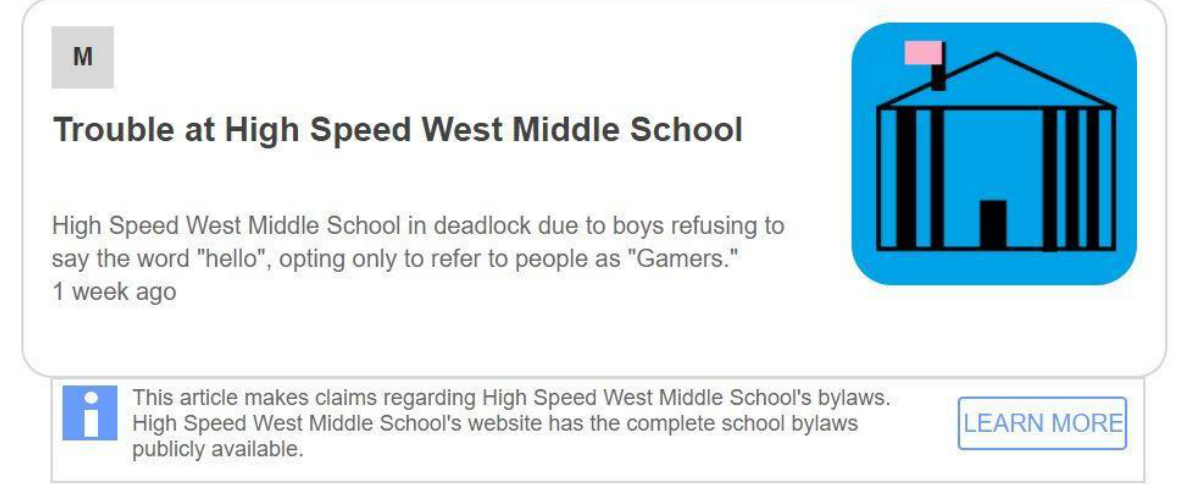
Figure 100. Supplemental information label [16].